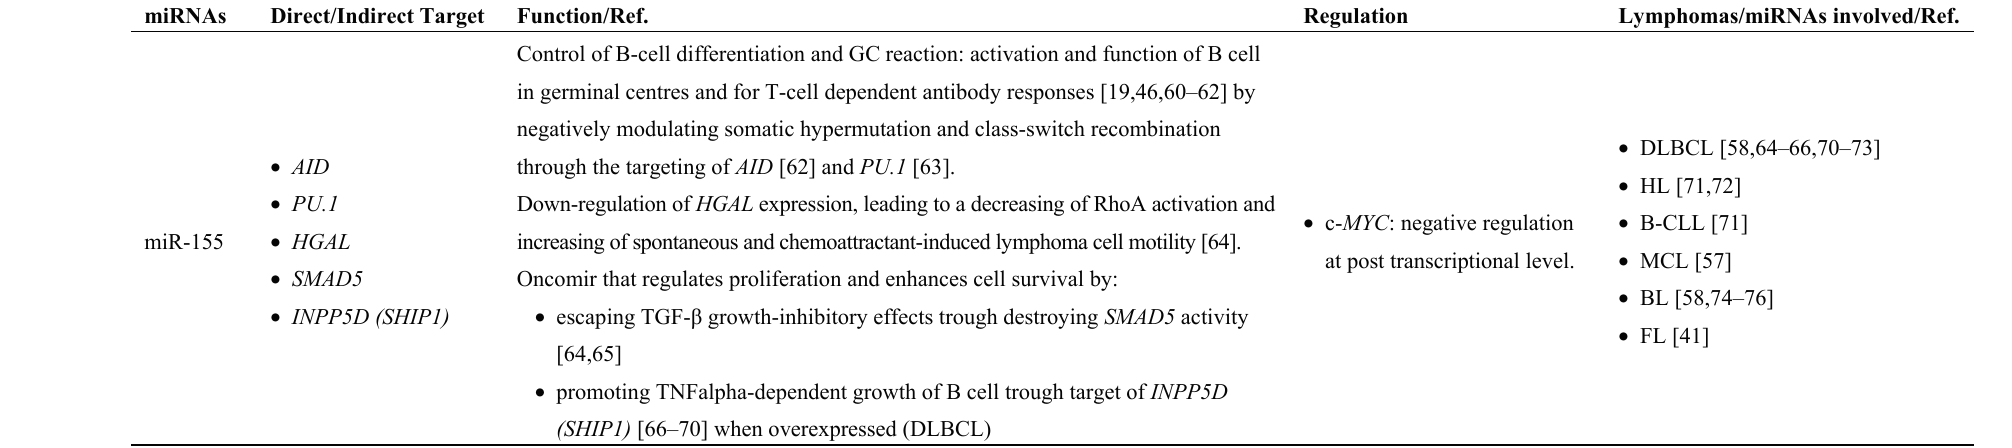
Table 1. Cont . miRNAs Direct/Indirect Target Function/Ref. Regulation Lymphomas/miRNAs